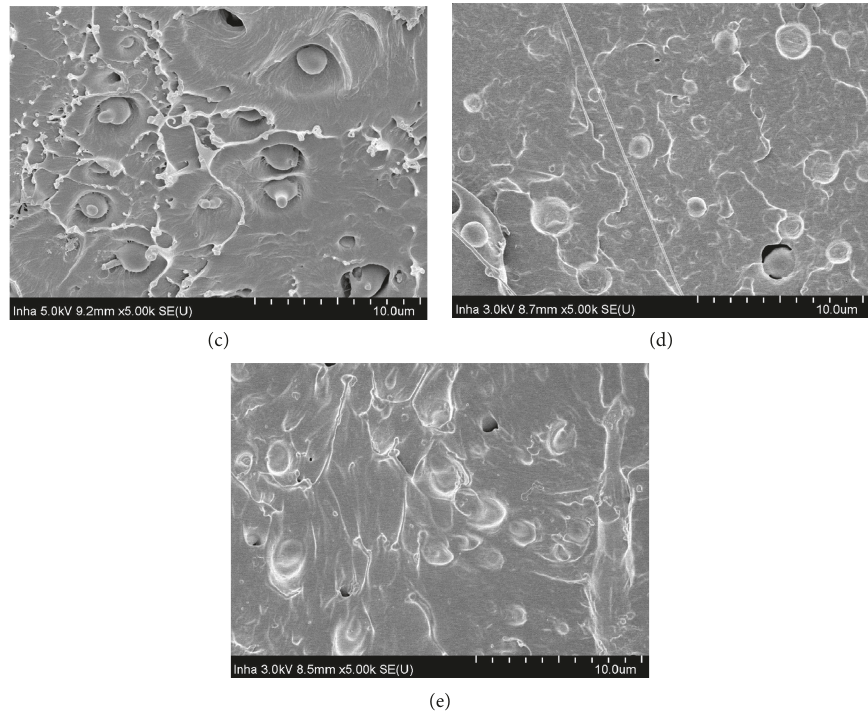
Figure 8: SEM micrographs of PLA/PCL/SiC composites after K IC tests: (a) PLA/PCL (2.5wt.% PCL); (b) 0.25wt.% SiC; (c) 0.5 wt.% SiC; (d) 0.75wt.% SiC; (e) 1.0wt.% SiC (magnification of